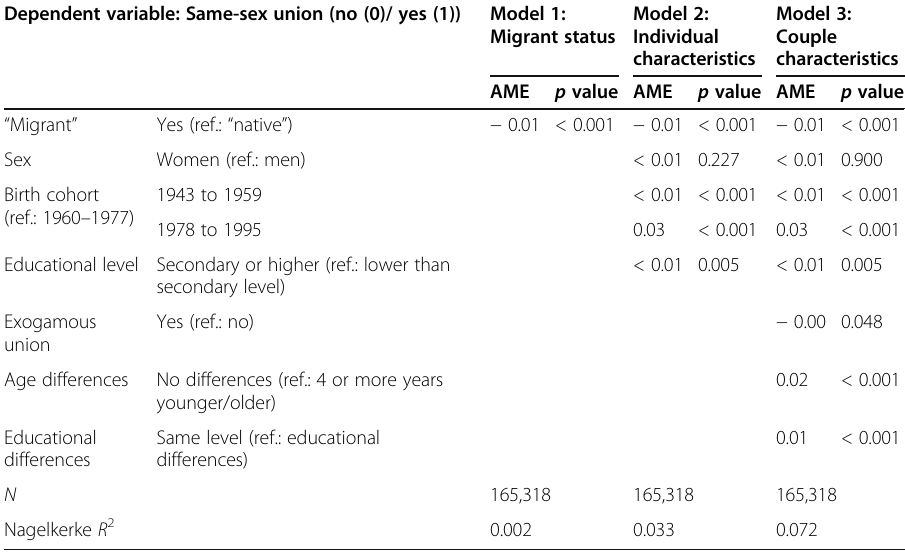
Table 6 Results of logistic regression